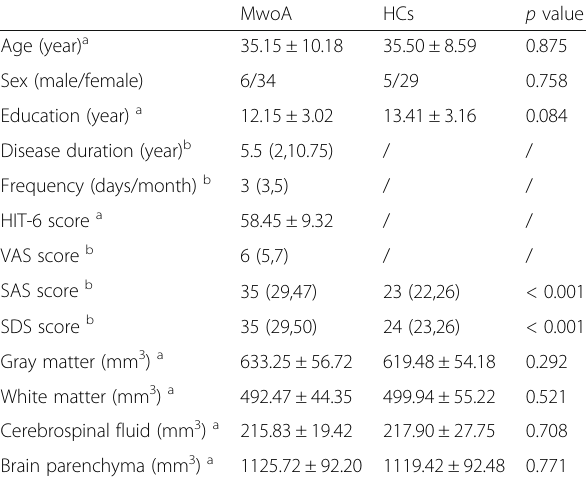
Table 1 Demographic, clinical and psychiatric characteristics of the participants